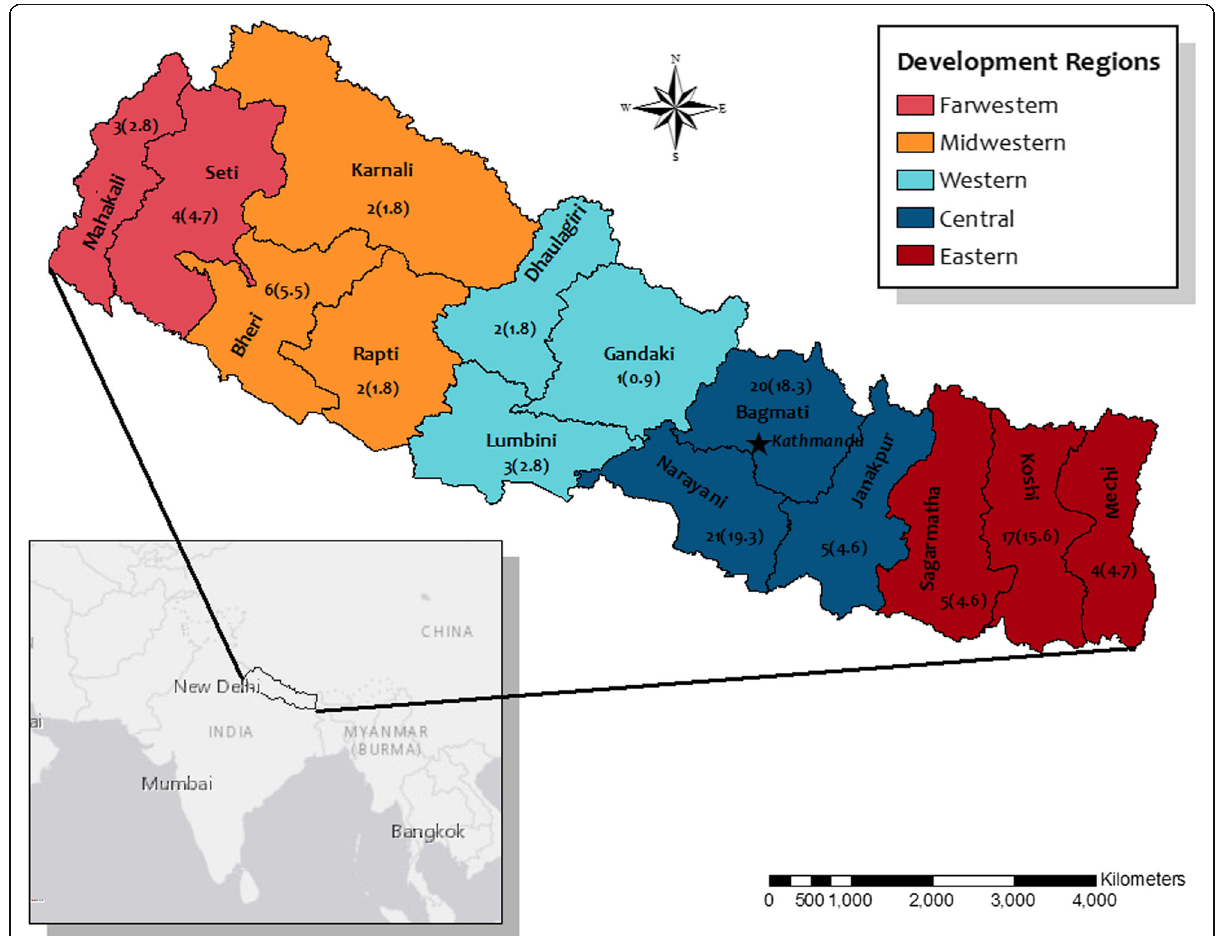
Fig. 1 Spatial distribution of health event reports in Nepal by administrative zone*. *Reports do not equal 108 as some reports occurred in multiple zones or the zone was not